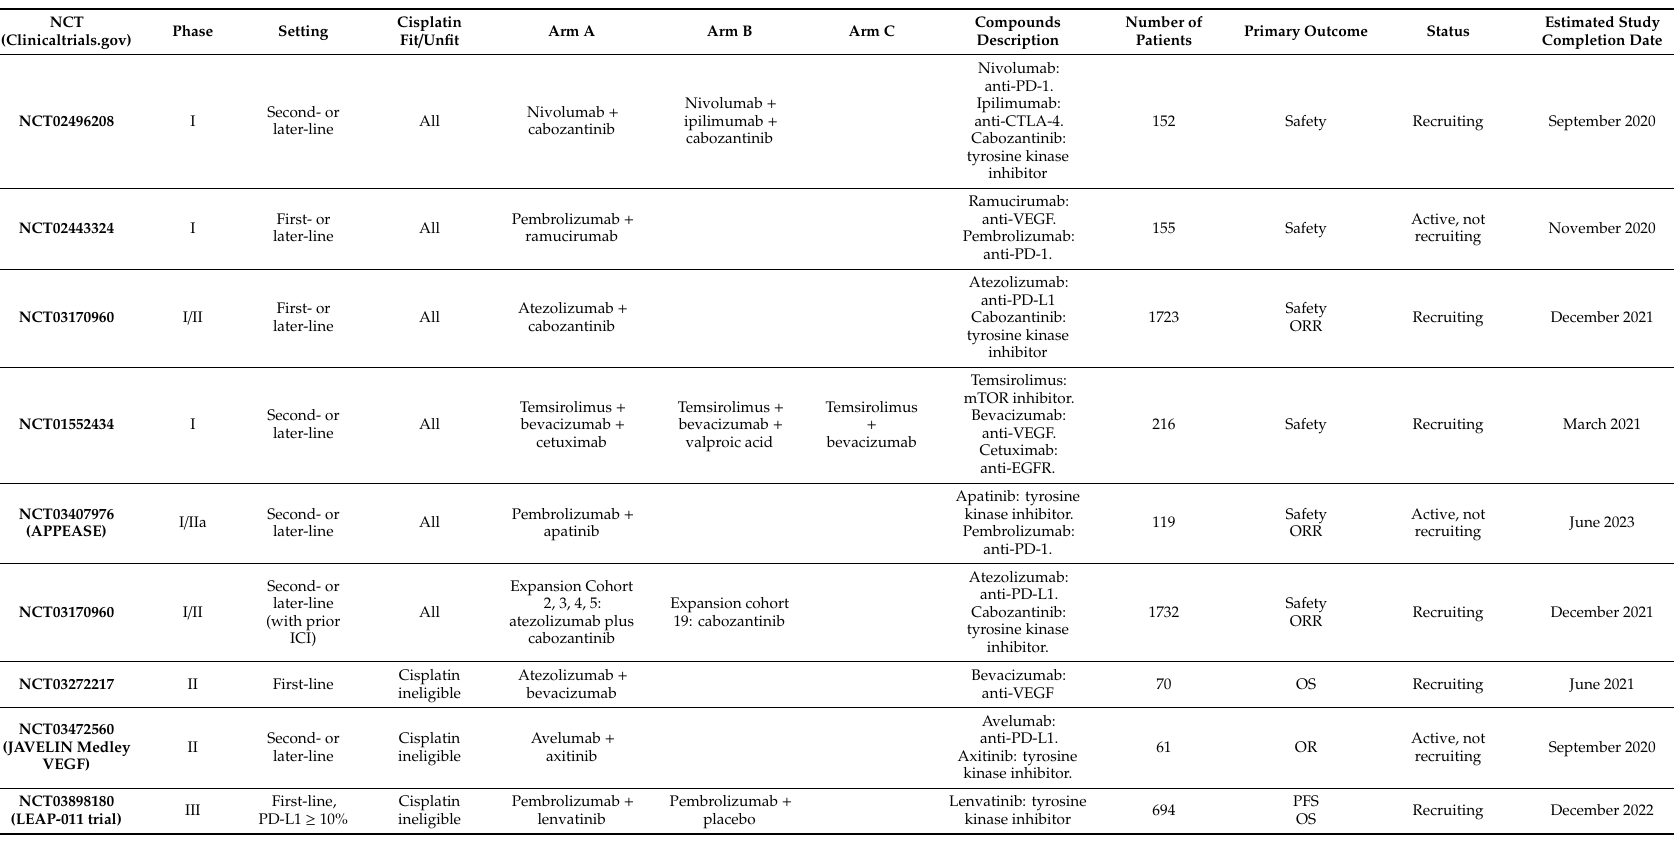
Table 3. Ongoing phase I / I / II trials of combinations between immune checkpoint inhibitors with antiangiogenic agents. ORR: overall response rate. PFS: progression-free survival. OS: overall